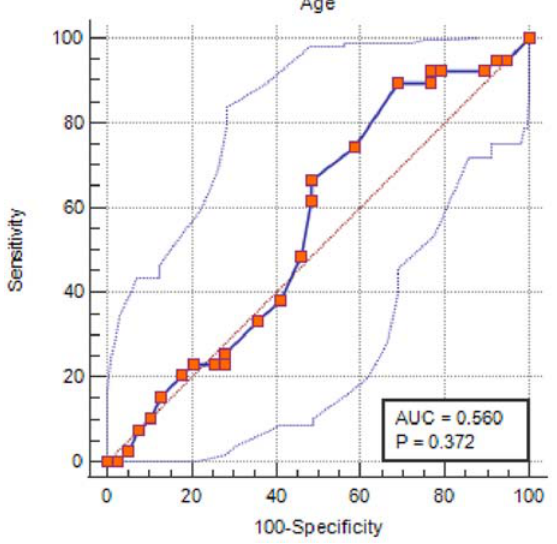
Figure 1. The area under curve (AUC) needed to be at least 0.80 p value lower than 0.05. However, as we can see in the graph, this was not the situation (0.56 vs. p = 0.37).